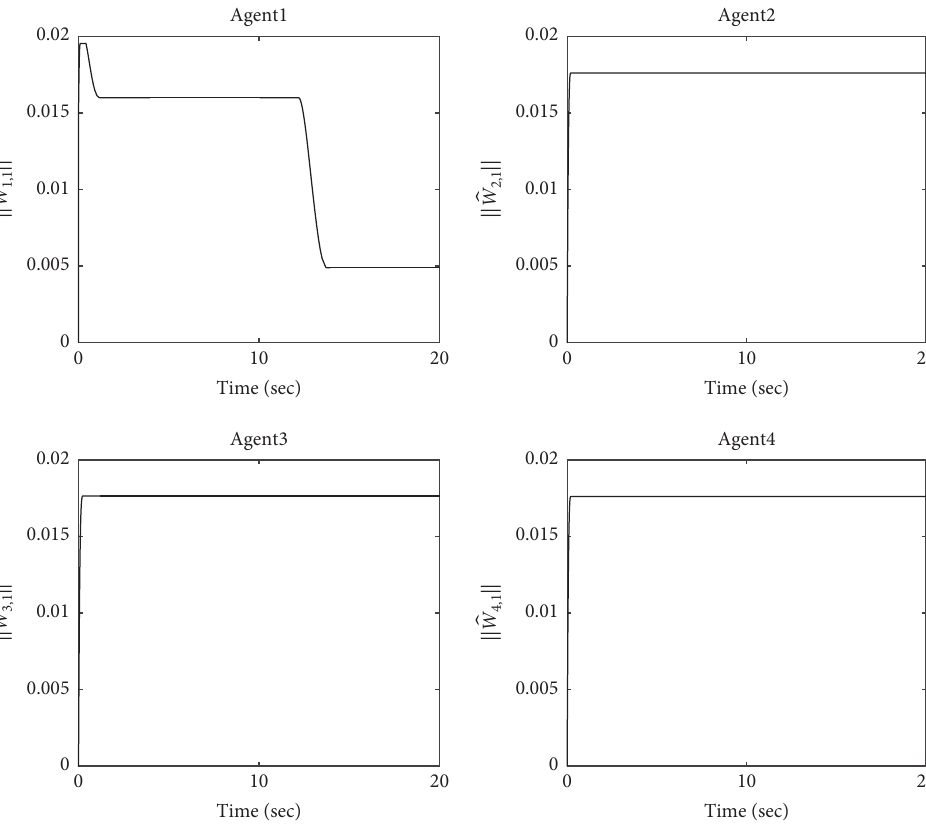
Figure 5: Trajectories of ‖ 􏽢 W